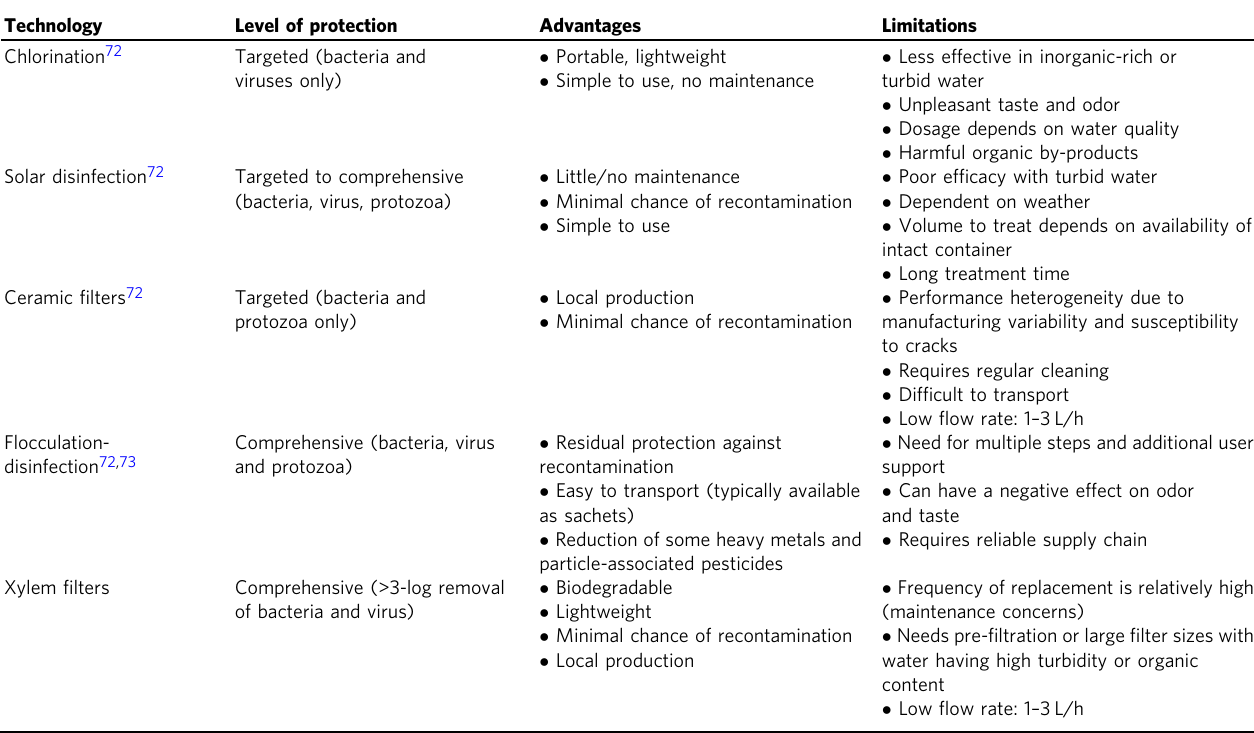
Table 2 Comparison of xylem fi lters with other low-cost water treatment technologies. Technology Level of protection Advantages